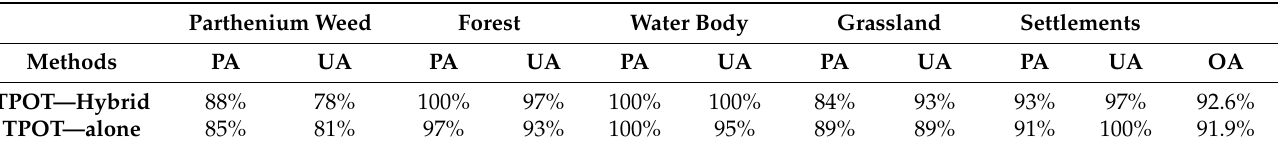
Table 3. Classification accuracies of the TPOT and the hybrid ReliefF-svmb-EXT-TPOT models. Parthenium Weed Forest Water Body Grassland